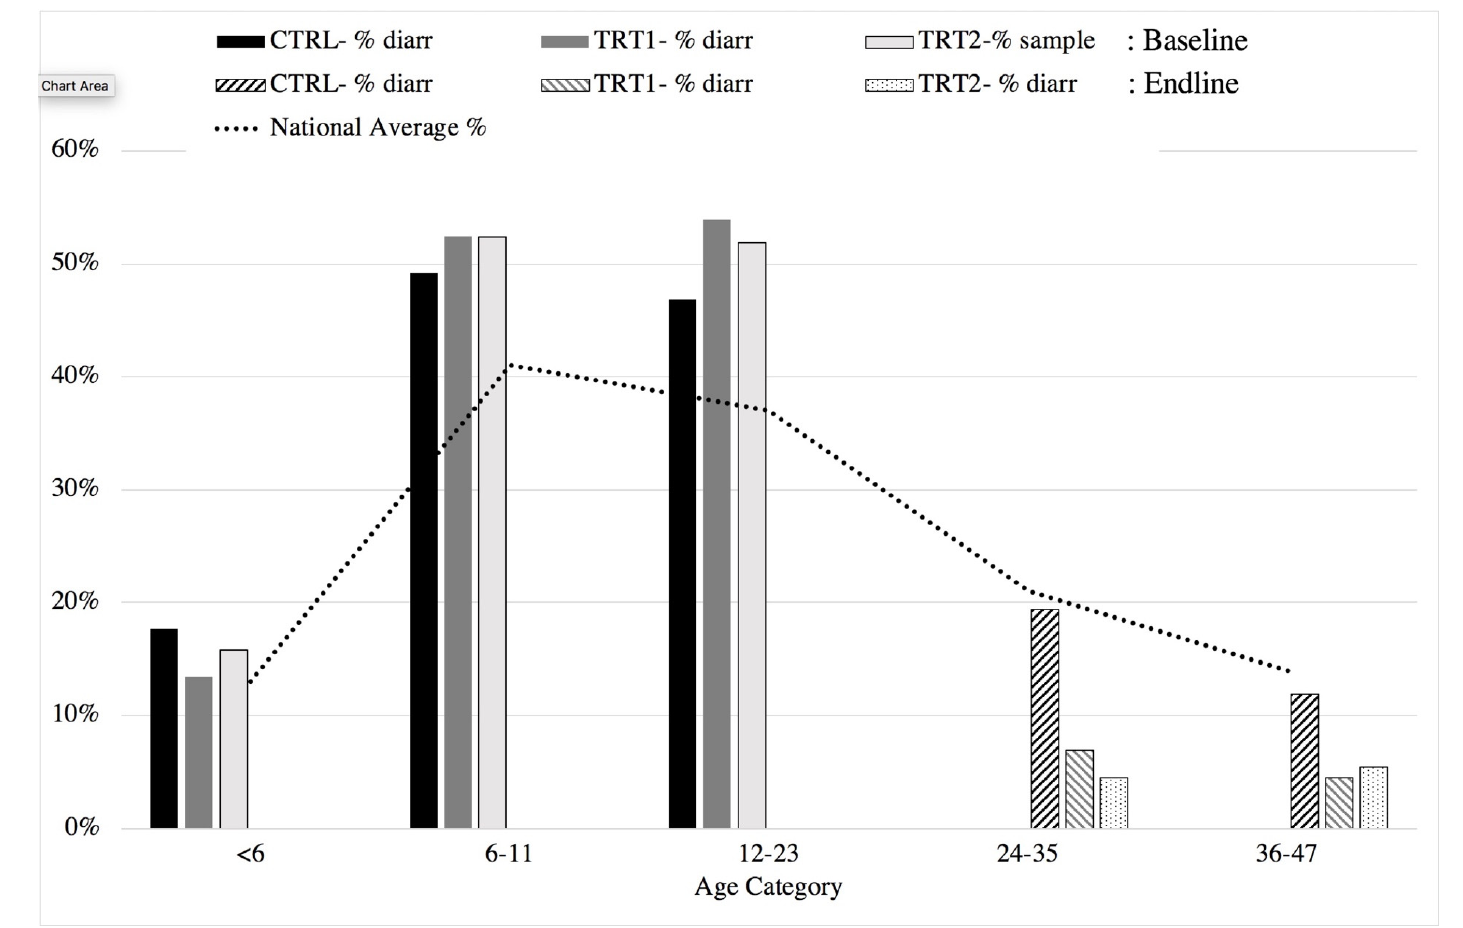
Figure 4. A summary of the percentage cases of diarrhoeal disease by age compared to national trends (baseline: 2017; end line: 2018).